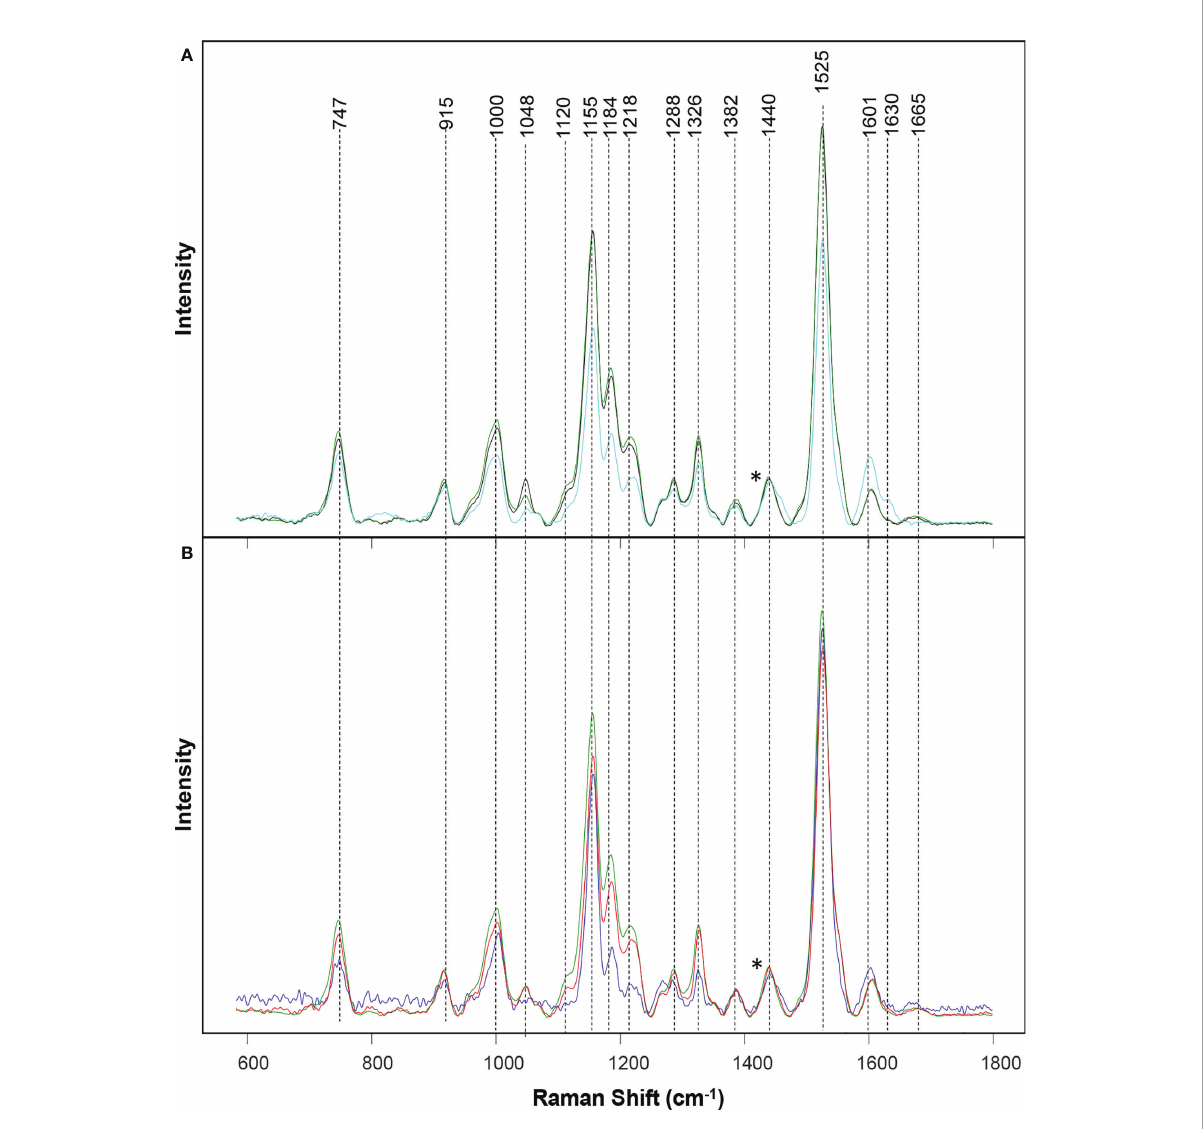
FIGURE 1 Raman spectra collected from leaves of healthy (green), ND- (light blue) and drought (black) stressed plants (A) , as well as wheat exposed to WSMV+TriMV infection (red) and aphid stress (blue) (B) . *Spectra normalized on 1,440 cm -1 vibrational band, which were assigned to CH2